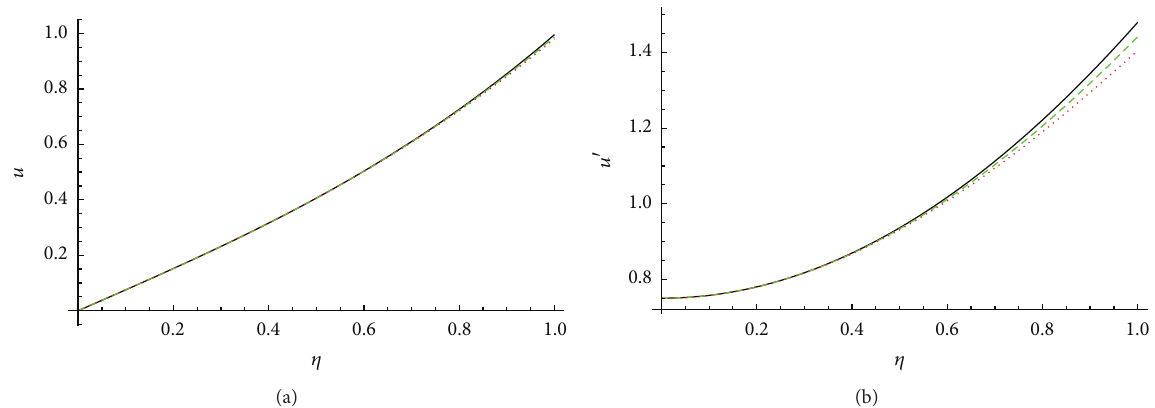
Figure 6: (a) Velocity profiles (normal velocity) for 𝑅 = 0.1 (continuous curve), 0.3 (dashed curve), and 0.5 (dotted curve) at 𝛼 = 4.0 , 𝛾 = 1 in case of slip boundary. (b) Velocity profiles (longitudinal velocity) for 𝑅 = 0.1 (continuous curve), 0.3 (dashed curve), and 0.5 (dotted curve) at 𝛼 = 4.0 , 𝛾 = 1 in case of slip